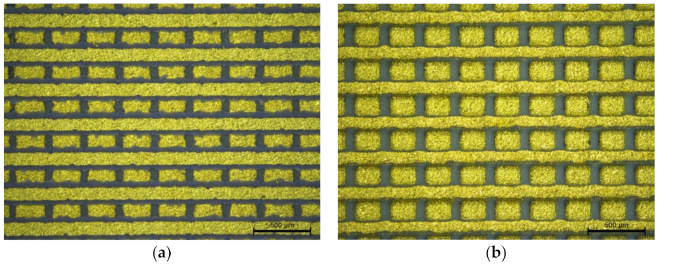
Figure 9. The image of the structure after co-firing utilizing two methods, ( a ) with a screen-printed dielectric layer (SS) and ( b ) with insulation made of LTCC tape (MS).